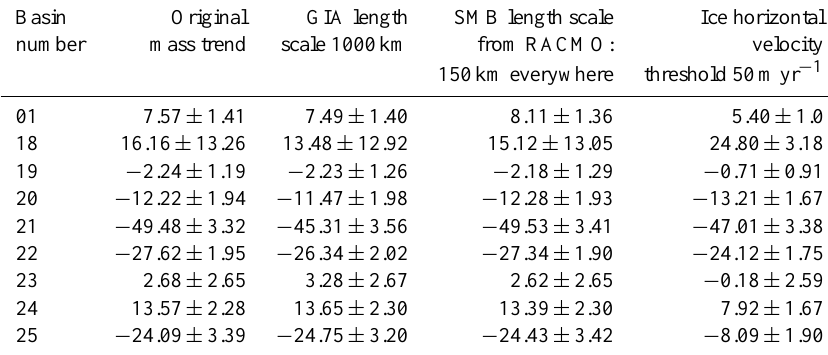
Table 4. Mass trend values for each basin shown in Fig. 8 for different values of the GIA length scale, SMB length scale, and ice surface velocity threshold. All values in columns 2–4 are in Gtyr − 1 . Basin Original GIA length from